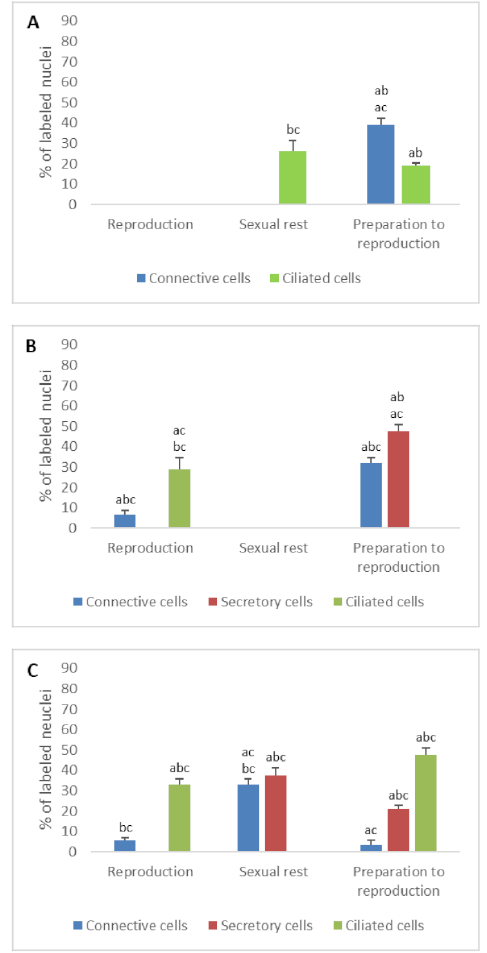
Figure 3. Percentage of ER α immunodetected in the different cell types of the genital tract of Typhlonectes compressicauda before ovulation and during the reproduction period (pregnant females) and sexual rest (quiescent females). Significant differences (ANOVA, α = 0.05) between the 3 groups of females (a: before ovulation; b: pregnant females; c: quiescent females) are reported with the letters a, b, c. ( A ) Ostium (connective cells n = 6, Pr > F: 0.000, ciliated cells n = 6, Pr > F: 0.07); ( B ) Tubal part (connective cells n = 6, Pr > F: 0.001, secretory cells n = 6, Pr > F: 0.000, ciliated cells n = 6, Pr > F: 0.005); ( C ) Uterus (connective cells n = 6, Pr > F: 0.001, secretory cells n = 6, Pr > F: 0.001, ciliated cells n = 6, Pr > F: